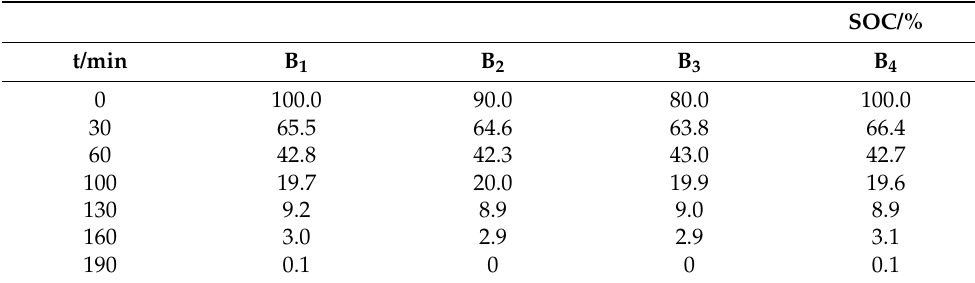
Table 4. Dynamic redundant battery management